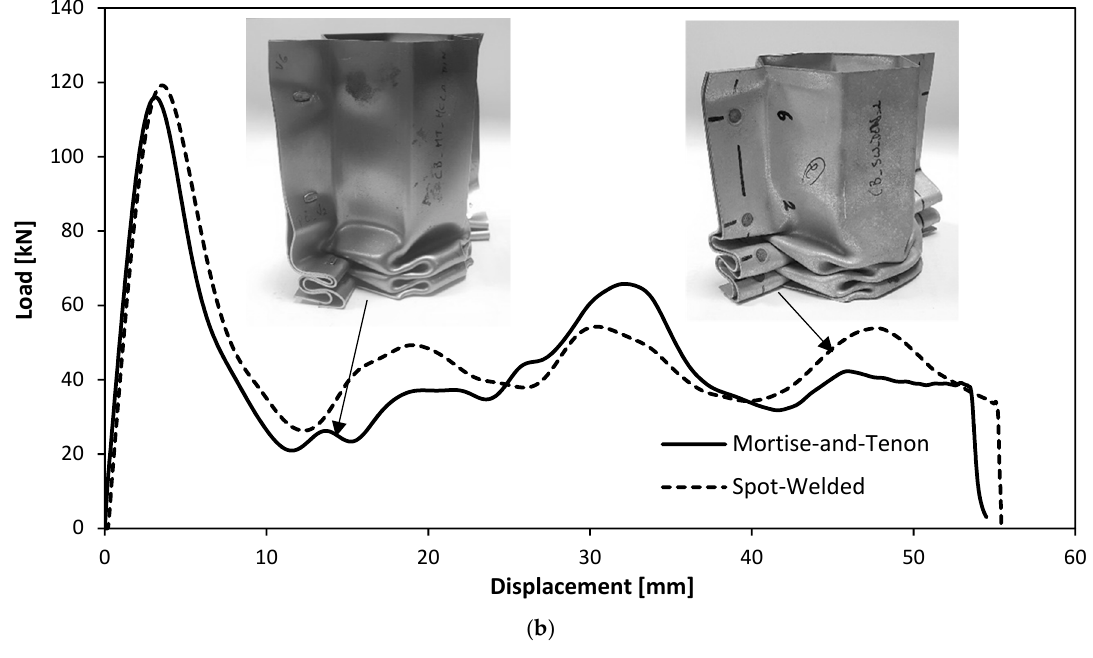
Figure 8. Experimental evolution of the force with displacement for the axial crush tests of thin-walled crash boxes with double-hat section assembled by sheet-bulk compression with “mortise-and-tenon” joints and by resistance spot-welding: ( a ) quasi-static tests; ( b ) dynamic tests.